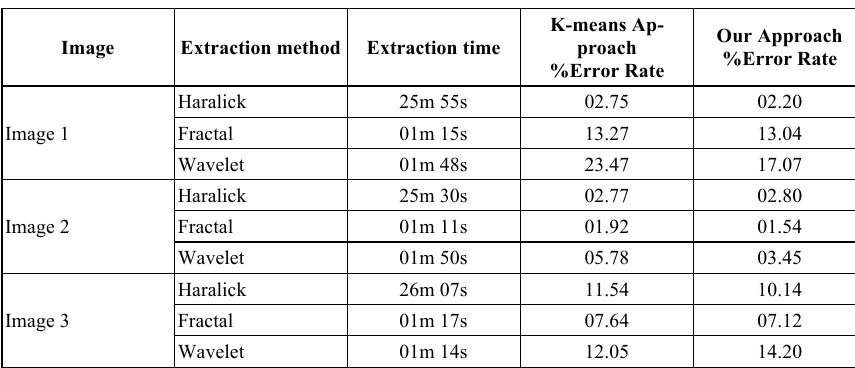
Table 1. Segmentation